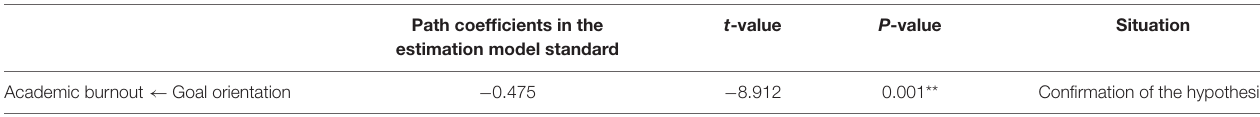
TABLE 5 | Relationship between goal orientation and academic burnout.